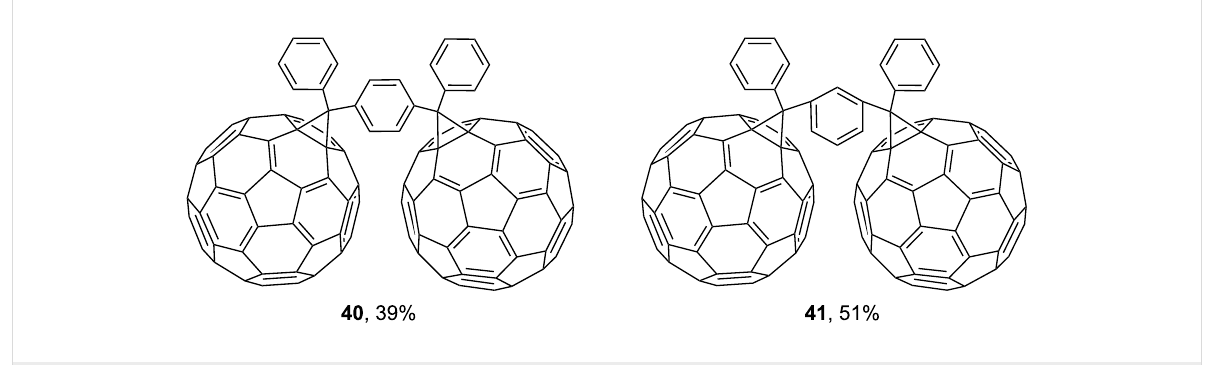
corresponding aminophenylfullerenes 49 and 51 (Scheme 15) [98,99]. C 60 adducts were doped with